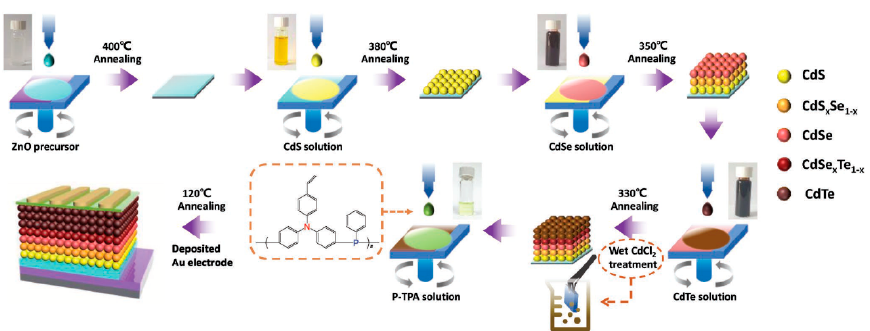
Figure 6. A schematic outline of the layer-by-layer process for making CdTe NC solar cells with a crosslinkable HTL. Reproduced with permission from [75], Copyright © 2019, WILEY-VCH Verlag GmbH & Co. KGaA, Weinheim.